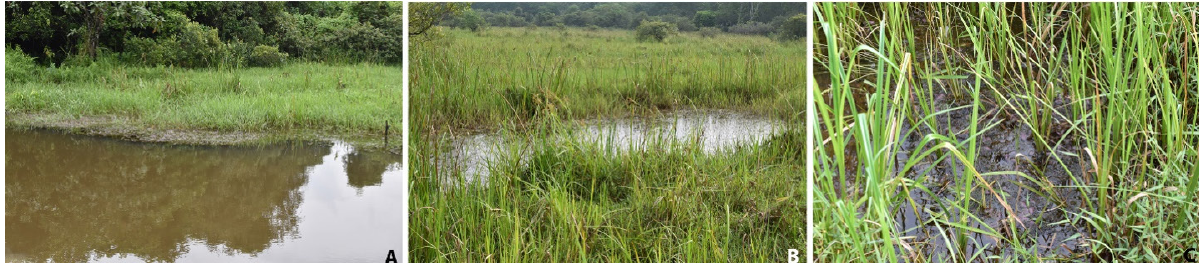
Figure 5: Infestations of C . furcata in Owilana area, the second location identified during the study. A. Populations along a stream concentrated towards the periphery; B. in a large pool and C. in a marshy